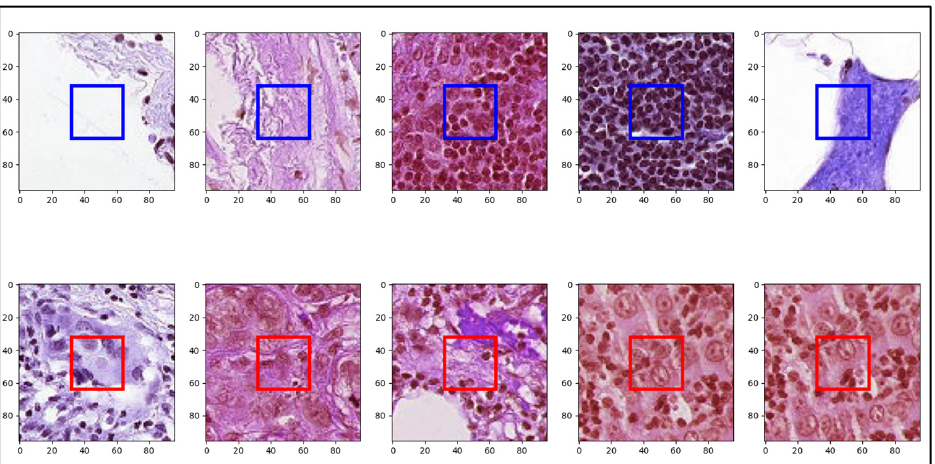
Figure 3. Random samples of the PatchCamelyon dataset that are stained with hematoxylin-eosin (H&E), blue (healthy tissue) and red squares (cancerous tissue) showing central regions.